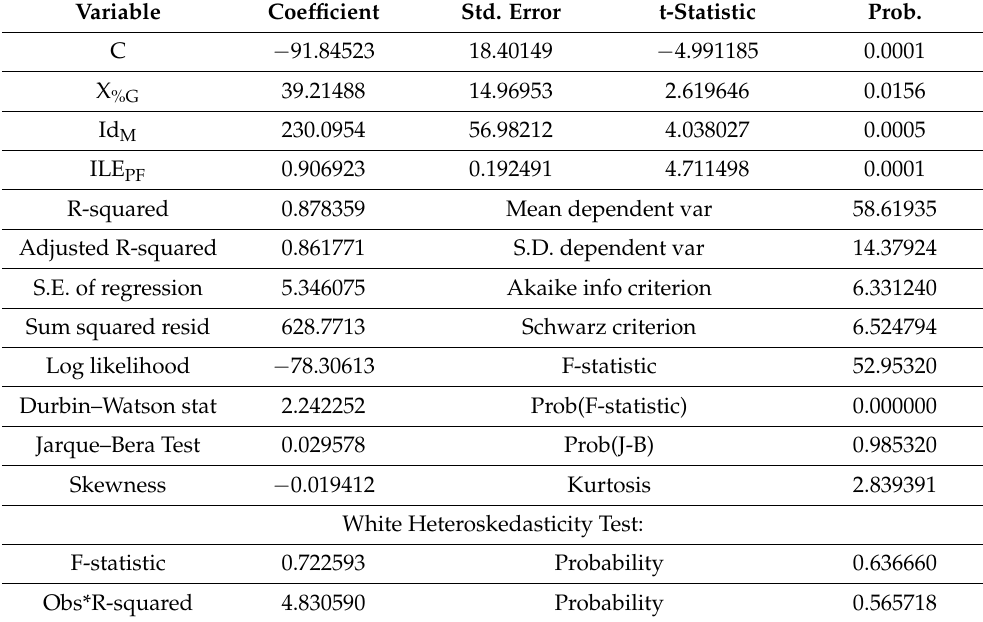
Table 6. S FDI_in(%GDP) model by X %G , Id M and ILE PF for HU.